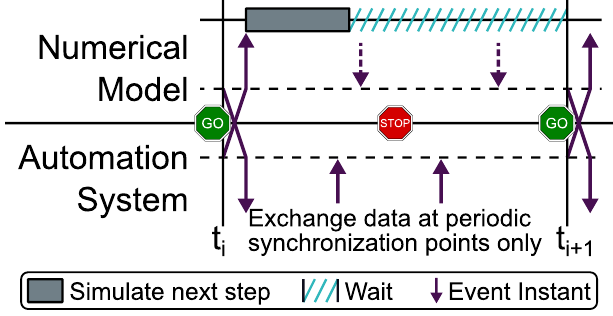
Figure 2. Periodic event